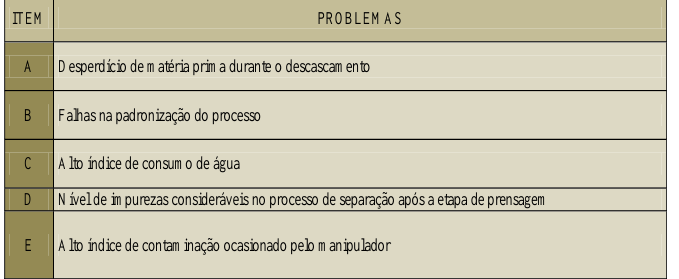
Fonte: Autores, (2017).